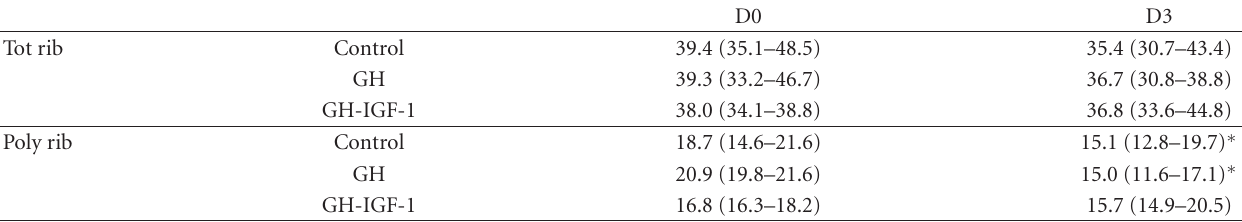
Table 8: Ribosome and polyribosome concentrations (OD/mg DNA) in skeletal muscle. D0